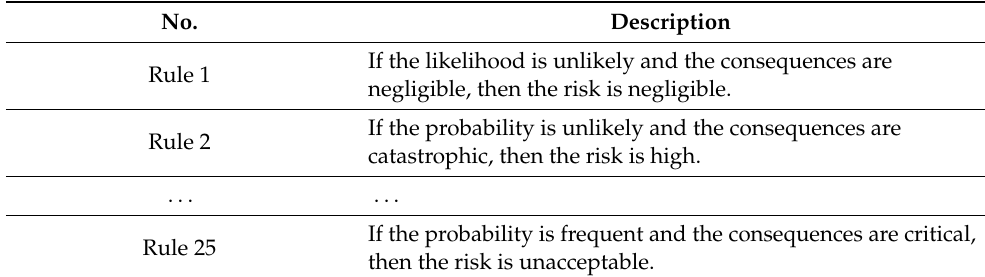
Table 2. Mathematical model rule table.